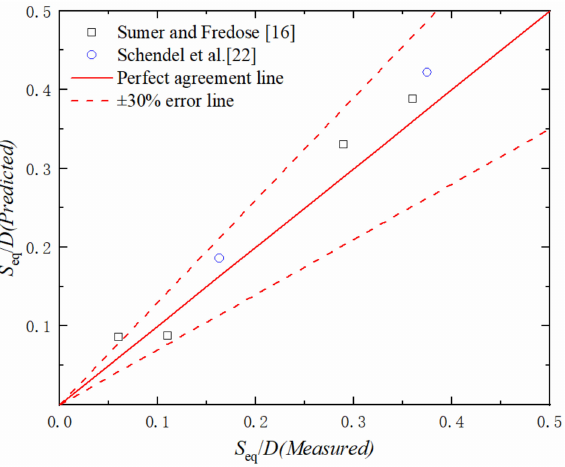
Figure 7. Comparison of equilibrium (or maximum) scour depth between the present study and Sumer and Fredsøe [16], Schendel et al.